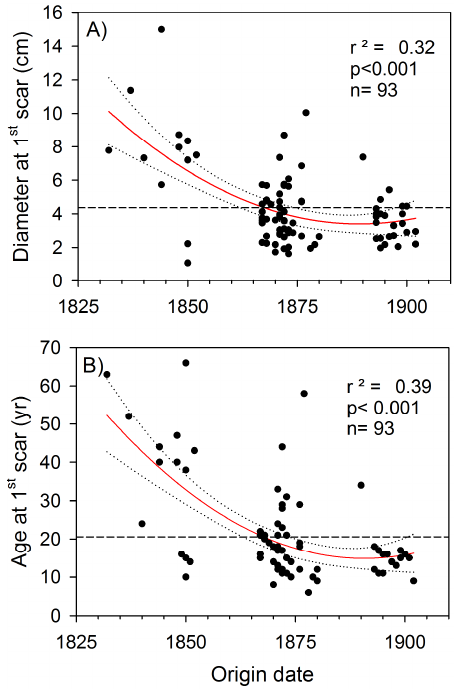
Figure 6. Diameter ( A ) and age ( B ) at first recorded scar as a function of origin date for Pinus banksiana trees. The r 2 value associated with a second ‐ order polynomial regression is indicated. The regression lines (with 95% CI) suggest that the first fire scar was recorded at a larger diameter (older age) in trees recruited prior to the 1860s. The horizontal dashed lines indicate the mean value.